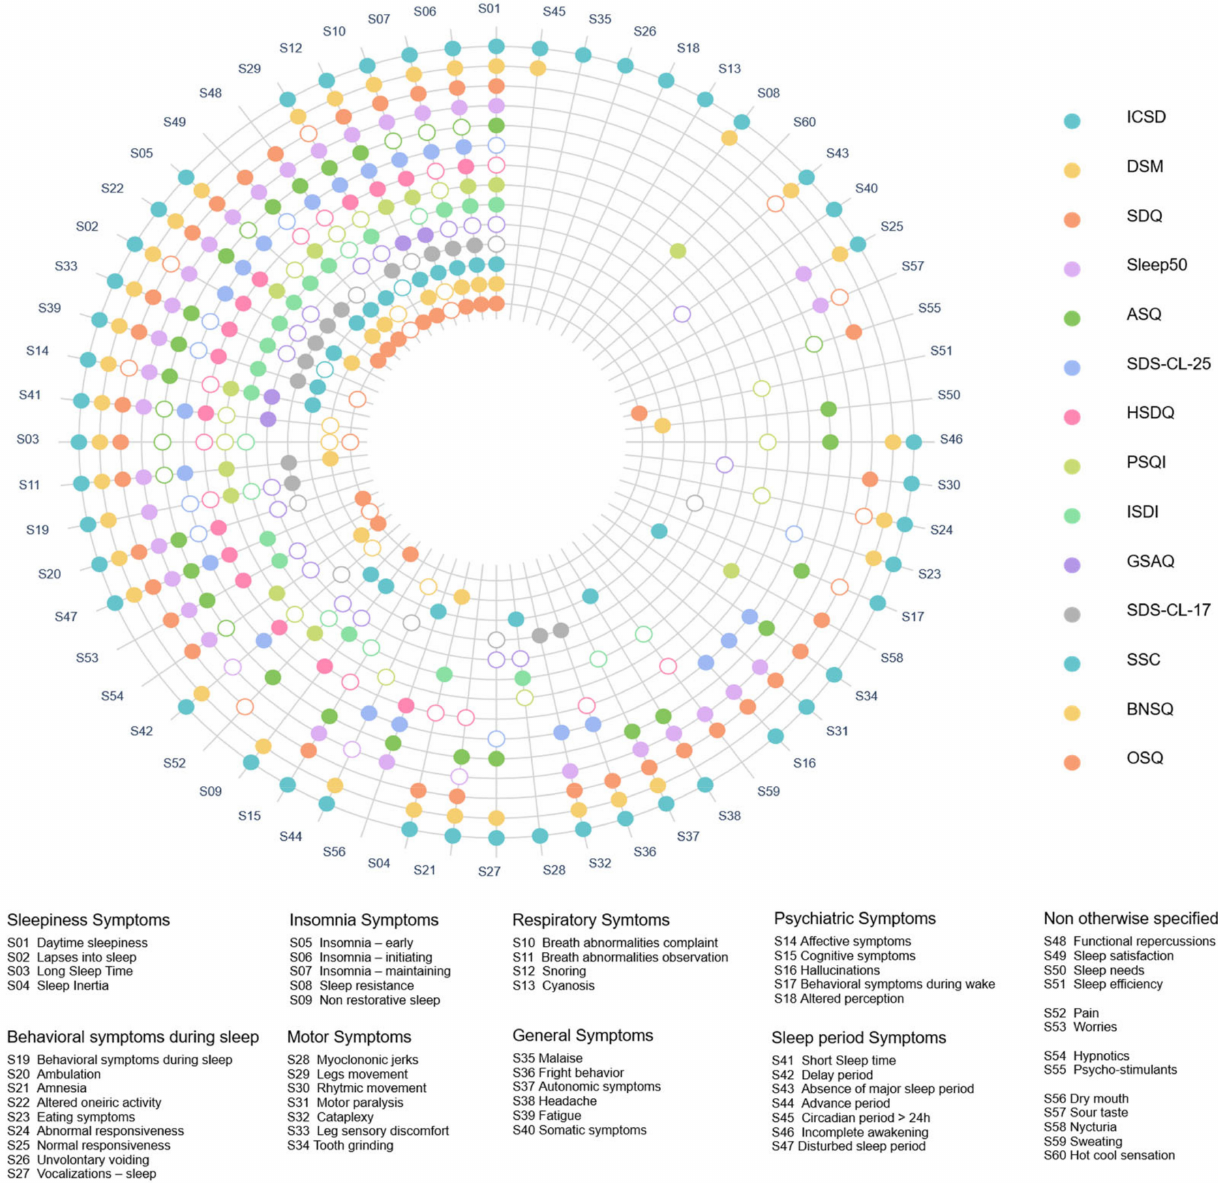
Figure 2. Content overlap of sleep symptoms in the 12 selected self-reported multiple sleep disorder screening questionnaires. Colored circles for a symptom indicate that this is a specific symptom, while empty circles indicate that this is a compound symptom. See also the interactive version of this Figure online: https://chart-studio.plotly.com/~vincent.martin/23/#/ accessed on 27 December 2022. ICSD: International Classification of Sleep Disorders, DSM: Diagnostic and Statistical Manual of Mental Disorders, SDQ: Sleep Disorder Questionnaire, ASQ: Auckland Sleep Questionnaire, HSDQ: Holland Sleep Disorders Questionnaire, SDS-CL-25: Sleep Disorder Symptom Checklist